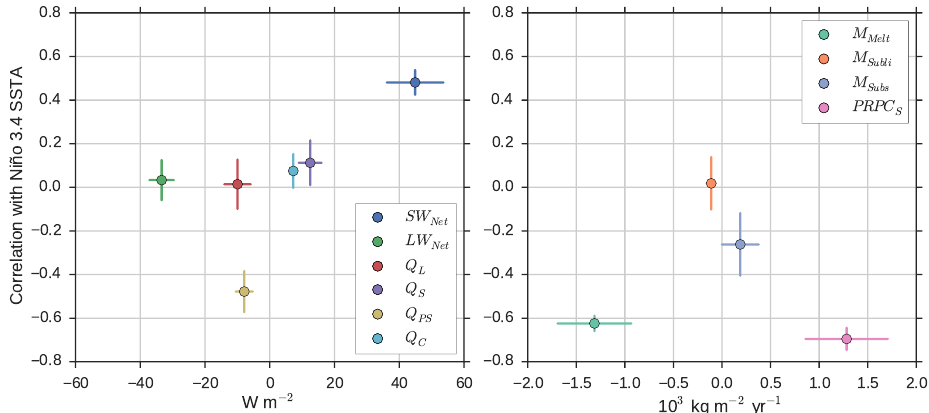
Figure 13. Glacier averaged contribution ( x axis) and correlation ( y axis) between annual Niño 3.4 SSTA and each SEB (left panel) and SMB (right panel) flux for 1980–2013. Note that the error bars are related to the uncertainty of the downscaling only (not of the calibration data) and that these results do not account for changing glacier